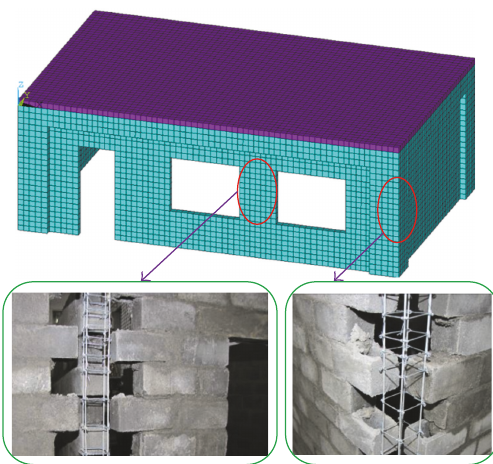
Figure 10: Experimental test on the dynamic response of the masonry structure.